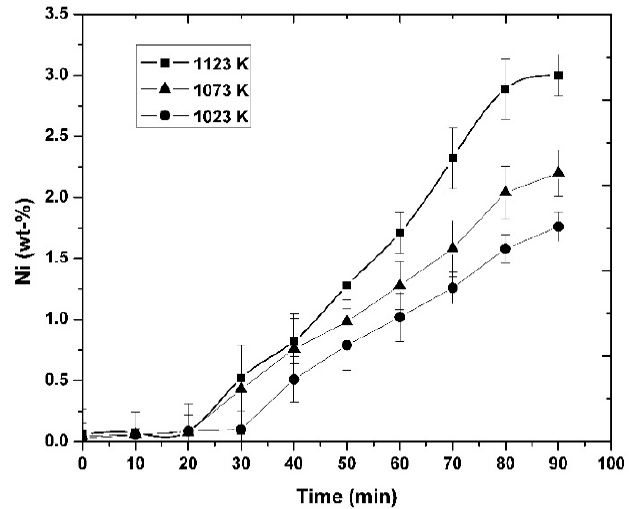
Figure 3. Increase in the nickel concentration as a function of injection time at the indicated temperatures for 3 wt-% Mg content in the alloy and at a constant agitation speed of 300 rpm.